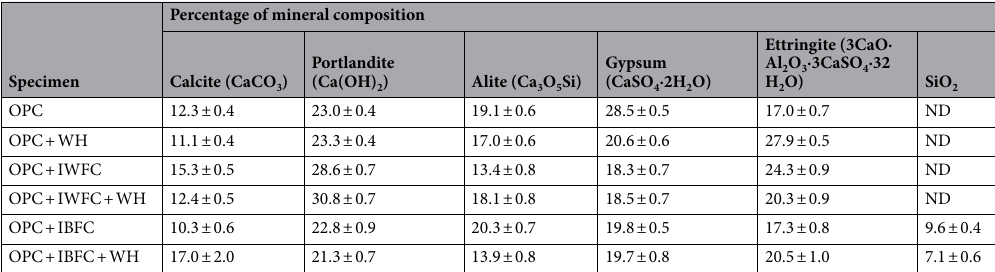
Table 3. Percentage of mineral compositions in cementitious composites analyzed by Rietveld Refinement method. Chemical compositions that are not detected are denoted as ND (not detected).